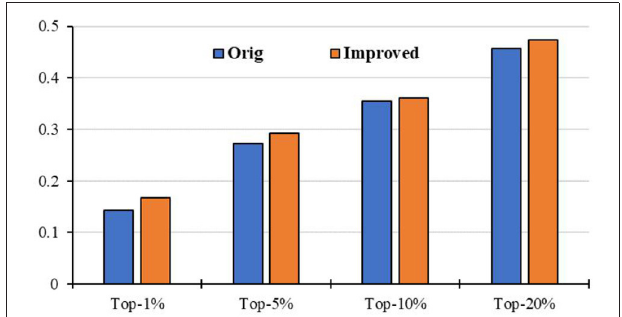
FIGURE 8 | Top- k Recall performance for all diseases in the PPI network.